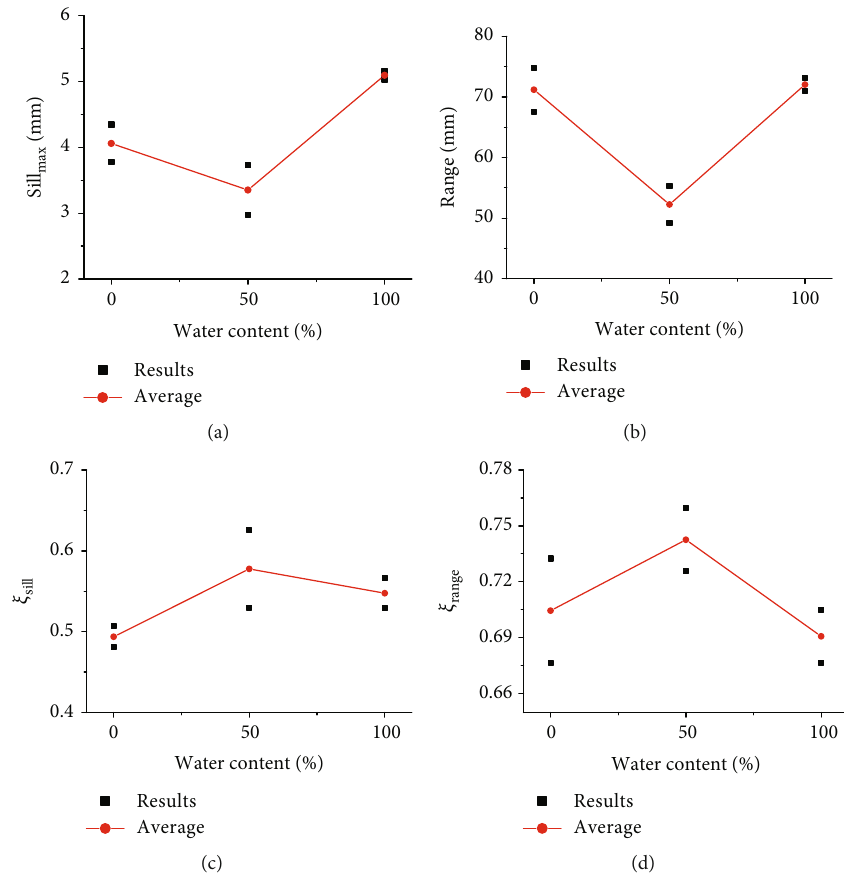
Figure 7: Curves of the parameters of the variogram function of the shear fracture surface under di ff erent water contents: (a) sill (b) range , (c) ξ , and (d) ξ sill range max